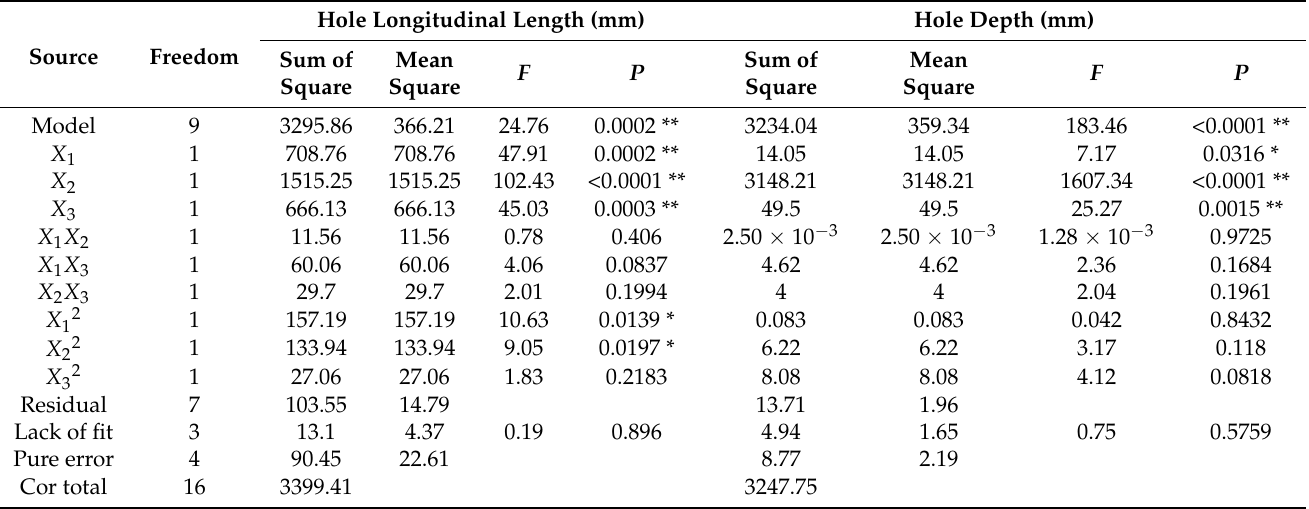
Table 6. Variance analysis of the regression